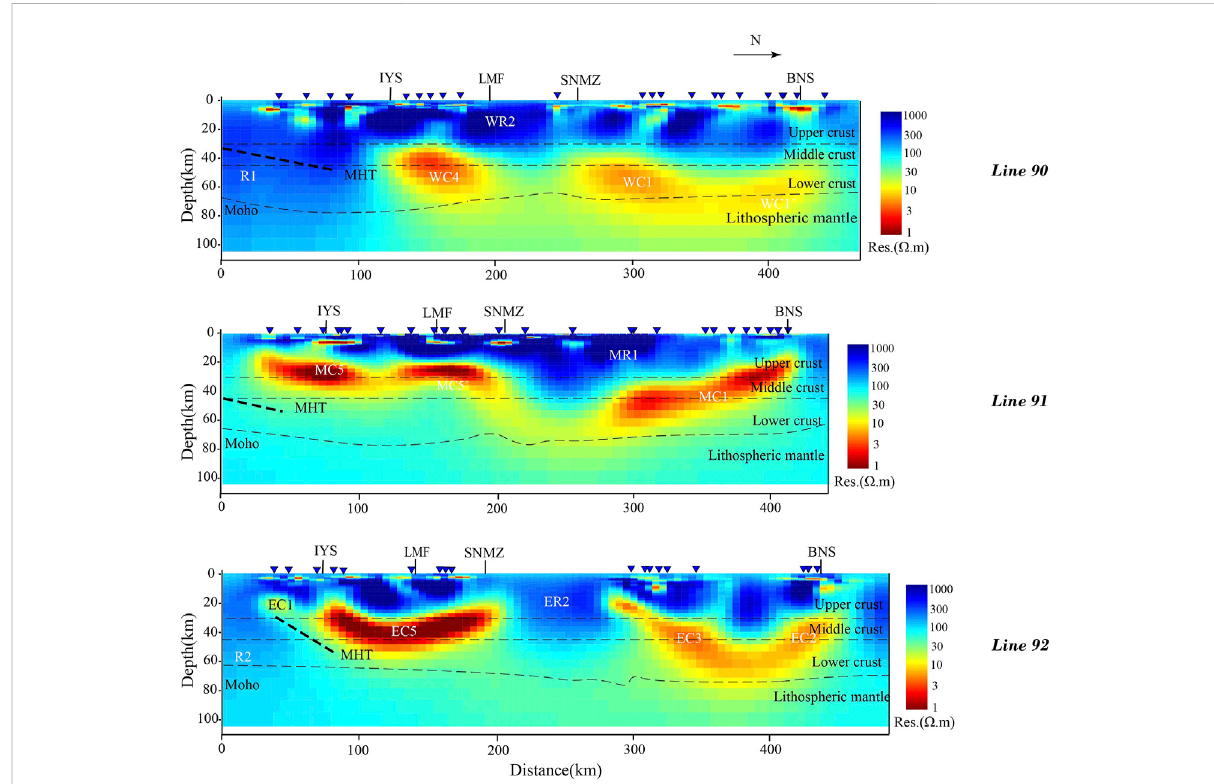
FIGURE 7 Crosssectionsofthe3-Delectricalresistivitymodel,approximatelyorientedSouthtoNorth(line90,line91,line92markedinFigure5).Inverted triangles: magnetotelluric measurement stations; Bold dashed black lines: possible locations of the main Himalayan thrust fault (MHT, Wei et al.,